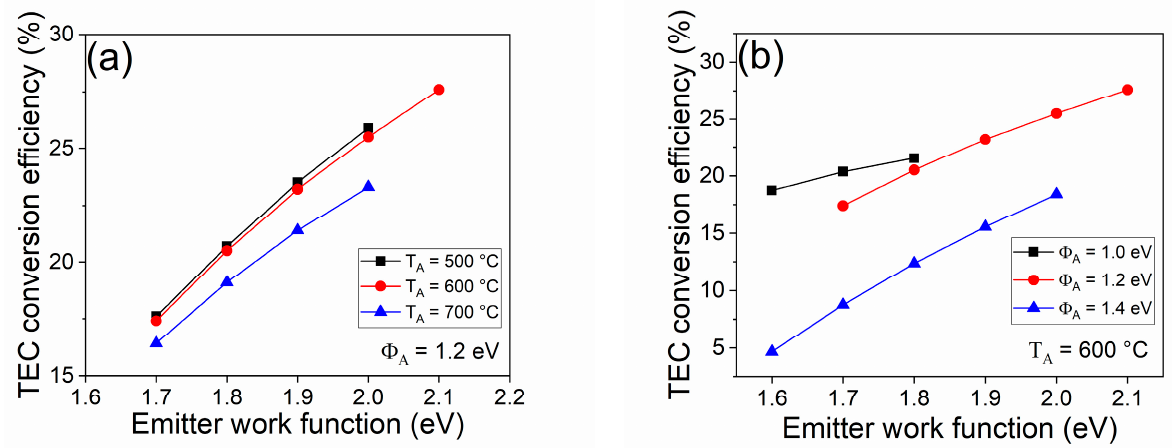
Figure 4. TEC conversion efficiency as a function of the emitter work function considering different conditions for the anode temperature ( a ) and the anode work function ( b ). All the values reported in the plots derive from calculations meeting all the constraints declared in the text. In particular, the values for which the cathode temperature results >1400 ◦ C and the temperature difference between the electrodes >700 ◦ C are not plotted because considered physically unfeasible.